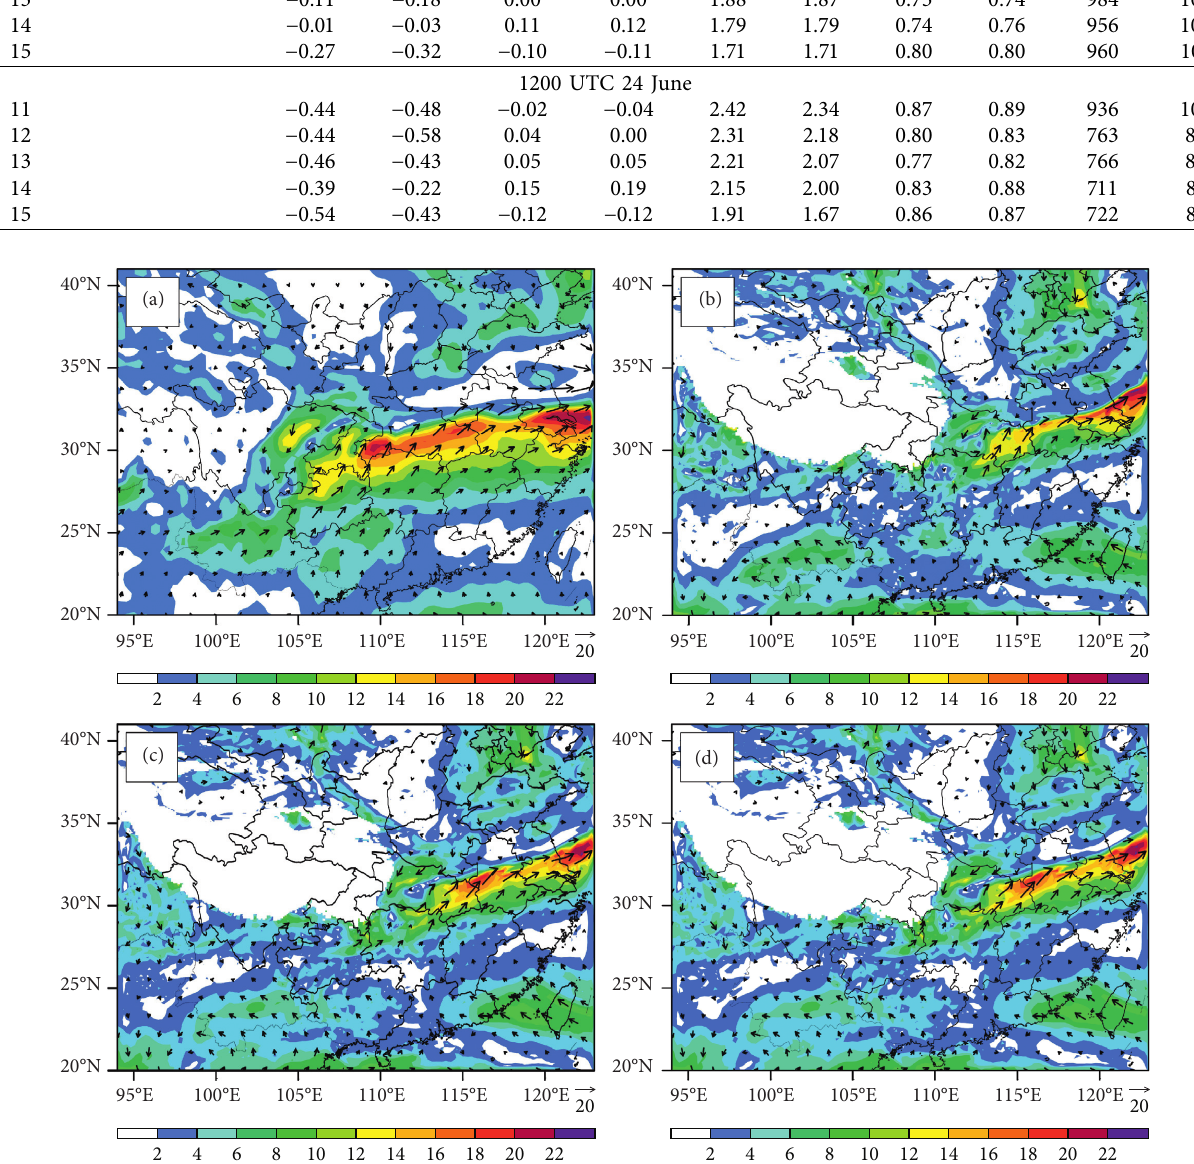
Figure 6: The 700 hPa water vapor flux (shaded; unit: g hPa − 1 cm − 1 s − 1 ) at 1200 UTC 24 June 2016 from the ERA-5 analysis (a), CN experiment (b), DY experiment (c), and AL experiment